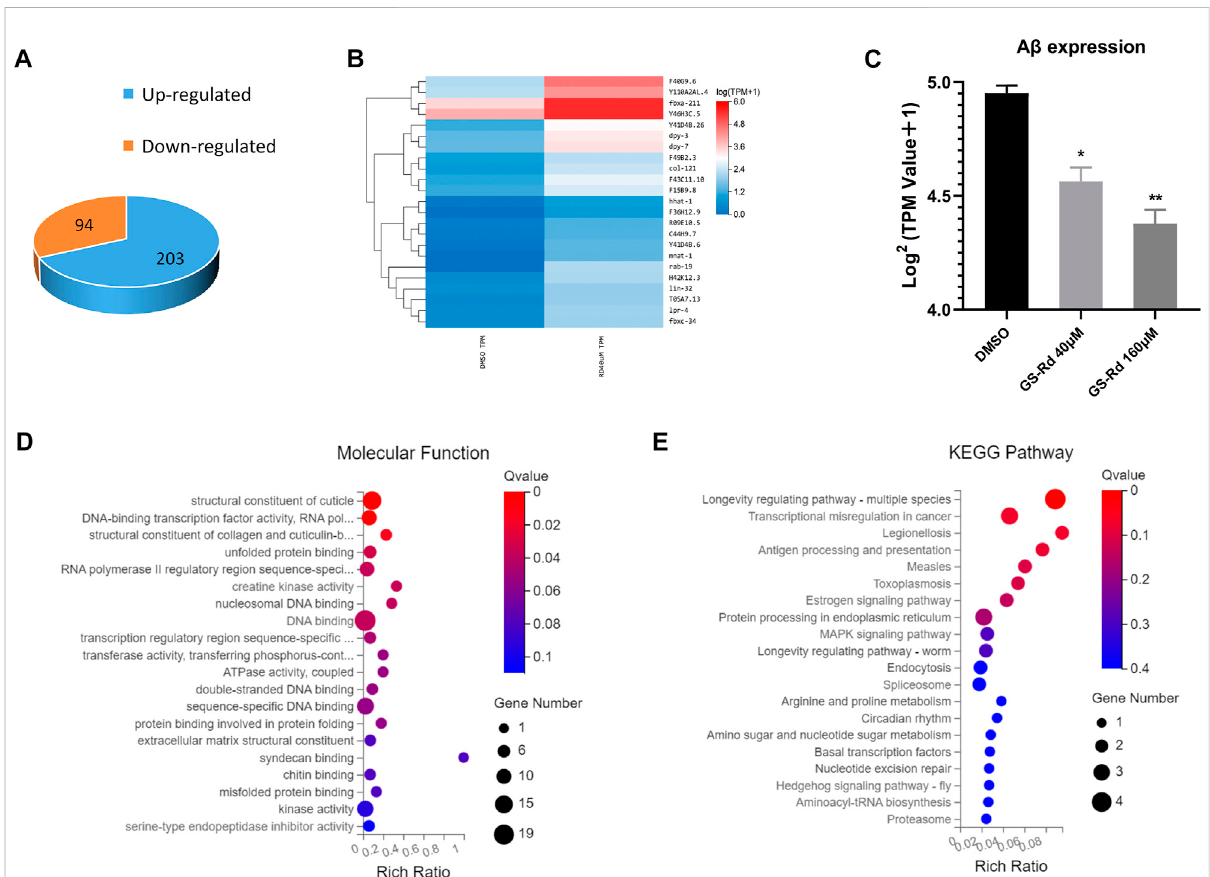
FIGURE 7 Analysis to the genes differentially expressed in GS-Rd treated CL4176 worms and the AD-associated pathwayswere enriched by RNA-Seq. (A) The number of differentially expressed genes between GS-Rd and DMSO treated CL4176 worms. log 2 (GS-Rd/DMSO) > |1|; p < 0.05 was applied. (B) TheheatmapofdifferentiallyexpressedgenesbetweenGS-RdandDMSOshowedtwomainclustersofupregulatedanddownregulatedgenes.Each column represents an experimental condition and each row represent log 2 Ratio value or log10 (FPKM+0.01) of a gene. (C) The A β mRNA expression level in GS-Rd and DMSO groups. (D) The GO analysis clari fi es the molecular function of the differentially expressed genes in the CL4176 strain. (E) Top KEGG pathways enriched by the differentially expressed genes in GS-Rd treated